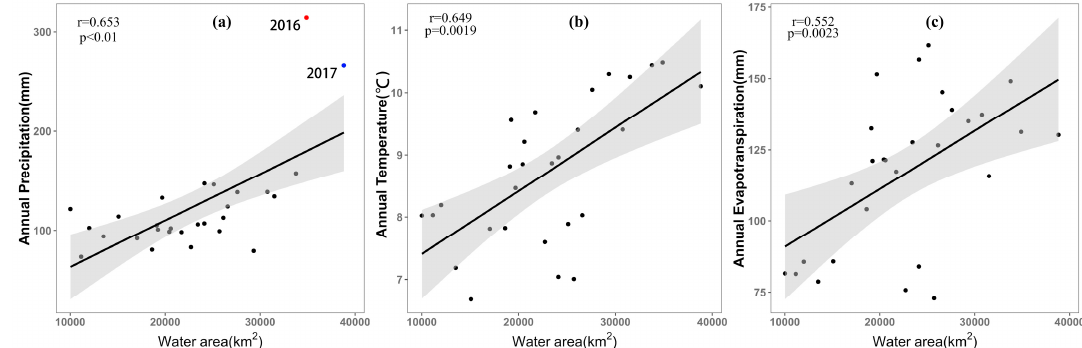
Figure 12. The Pearson correlation coe ffi cient between water area and ( a ) annual precipitation (The red dot represents 2016 and the blue dot represents 2017), ( b ) annual temperature, and ( c ) annual evapotranspiration from 1992–2019. The black lines in the figure are linear regression curves. The gray area represents the 95% confidence